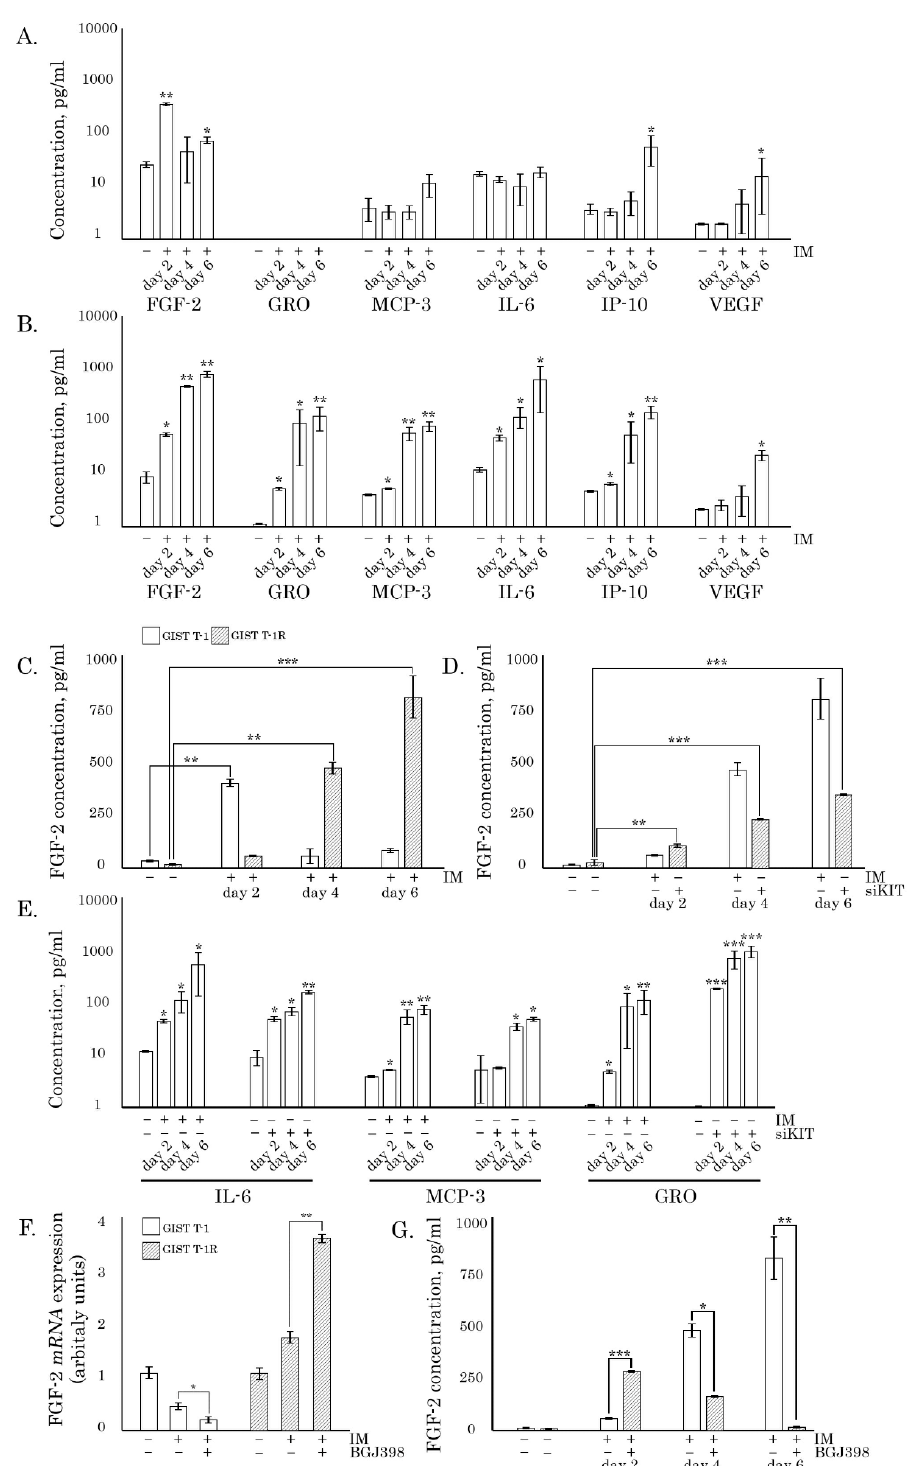
Figure 1. KIT inhibition induces the changes in gastrointestinal stromal tumor (GIST) secretome. ( A ) Median chemokine expression levels in the cell culture supernatants of imatinib mesylate (IM) ‐ treated (1 μ mol/L) GIST T ‐ 1 cells compared with non ‐ treated controls. ( B ) Median chemokine expression levels in the cell culture supernatants of IM ‐ resistant GIST T ‐ 1R cells treated with IM (1 μ mol/L) compared with non-treated controls. ( C ) FGF-2 levels in supernatants of IM-naive vs. resistant GISTs treated with IM (1 µ mol / L) for 2–6 days. ( D ) Comparative assessment of FGF-2 levels in cell culture supernatants of GIST T-1R cells treated with IM (1 µ mol / L) or transfected with siRNA KIT . ( E ) Comparative